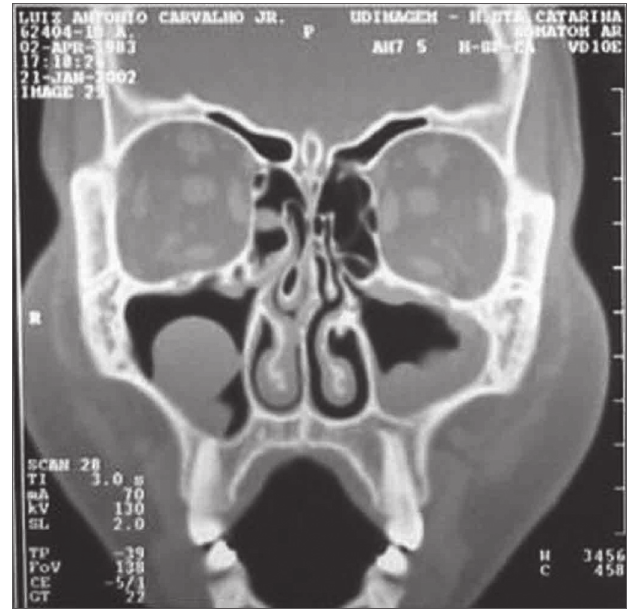
Figura 1. Tomografia Computadorizada de seios paranasais com varia- ções anatômicas de transplantado de células-tronco hematopoiética: concha bolhosa e desvio